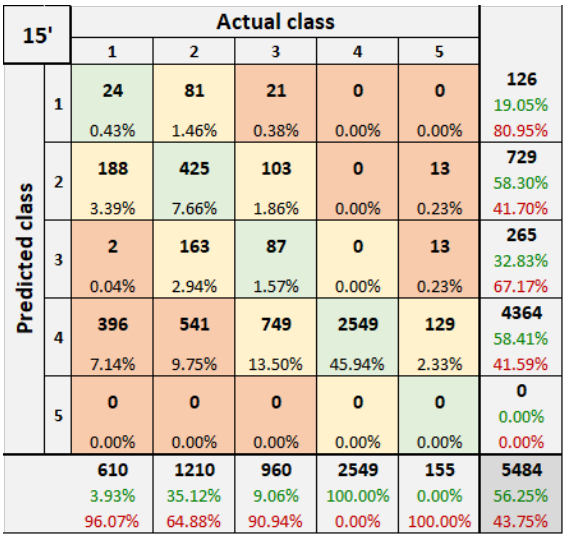
Figure 8. Confusion matrix corresponding to a time horizon of 15 min.